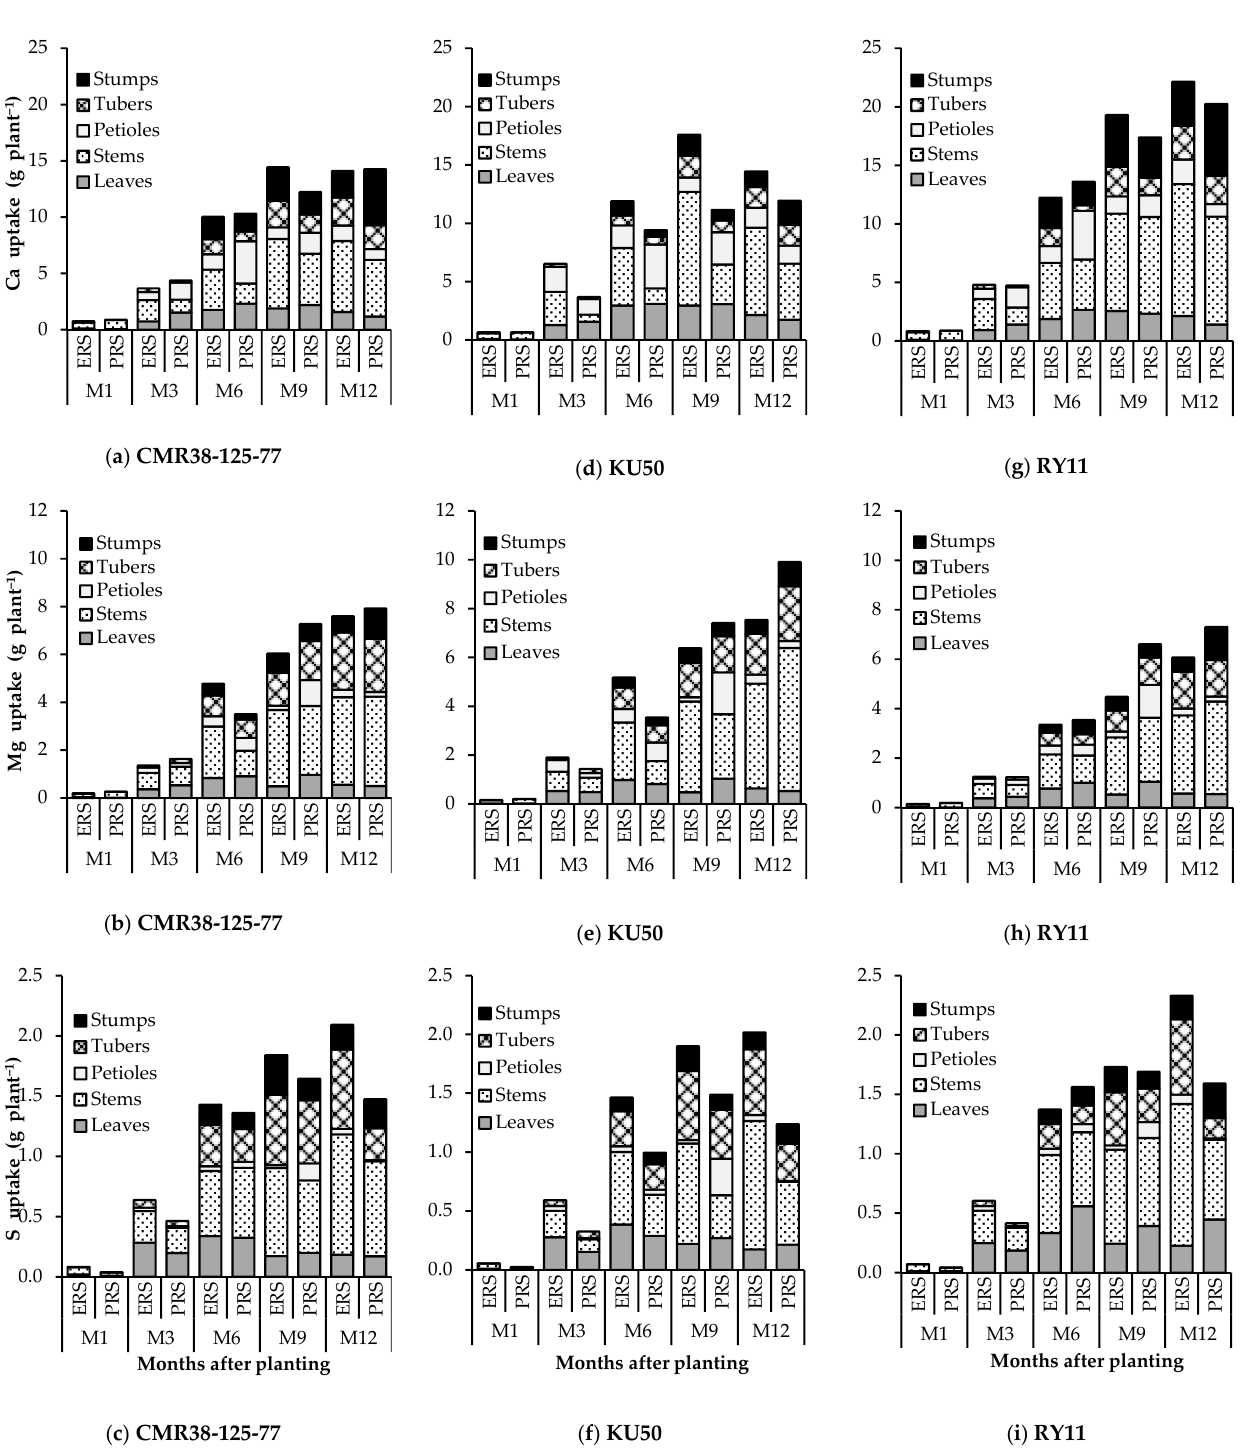
Figure 5. ( a – i ) Accumulation and distribution of calcium, magnesium and sulfur (g plant − 1 ) of three cassava genotypes in the early rainy season (ERS) and post rainy season (PRS) with full irrigation. Ca = calcium; Mg = magnesium; S = sulfur; KU50 = Kasetsart 50; RY11 = Rayong 11.